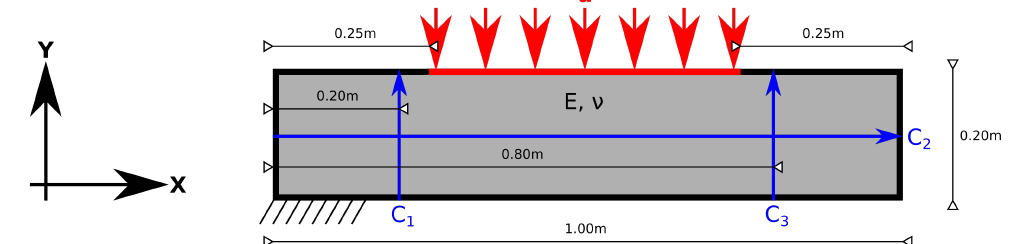
Figure 1. Mechanical study for LBMS approach validation. Black frontiers are fixed boundary conditions. A displacement is imposed across the vector u described with black, as is depicted on the left. Solid material properties are defined through Young’s modulus E and Poisson’s ratio ν . Blue oriented curves C 1 , C 2 and C 3 are used for post-processing. All dimensions are given in